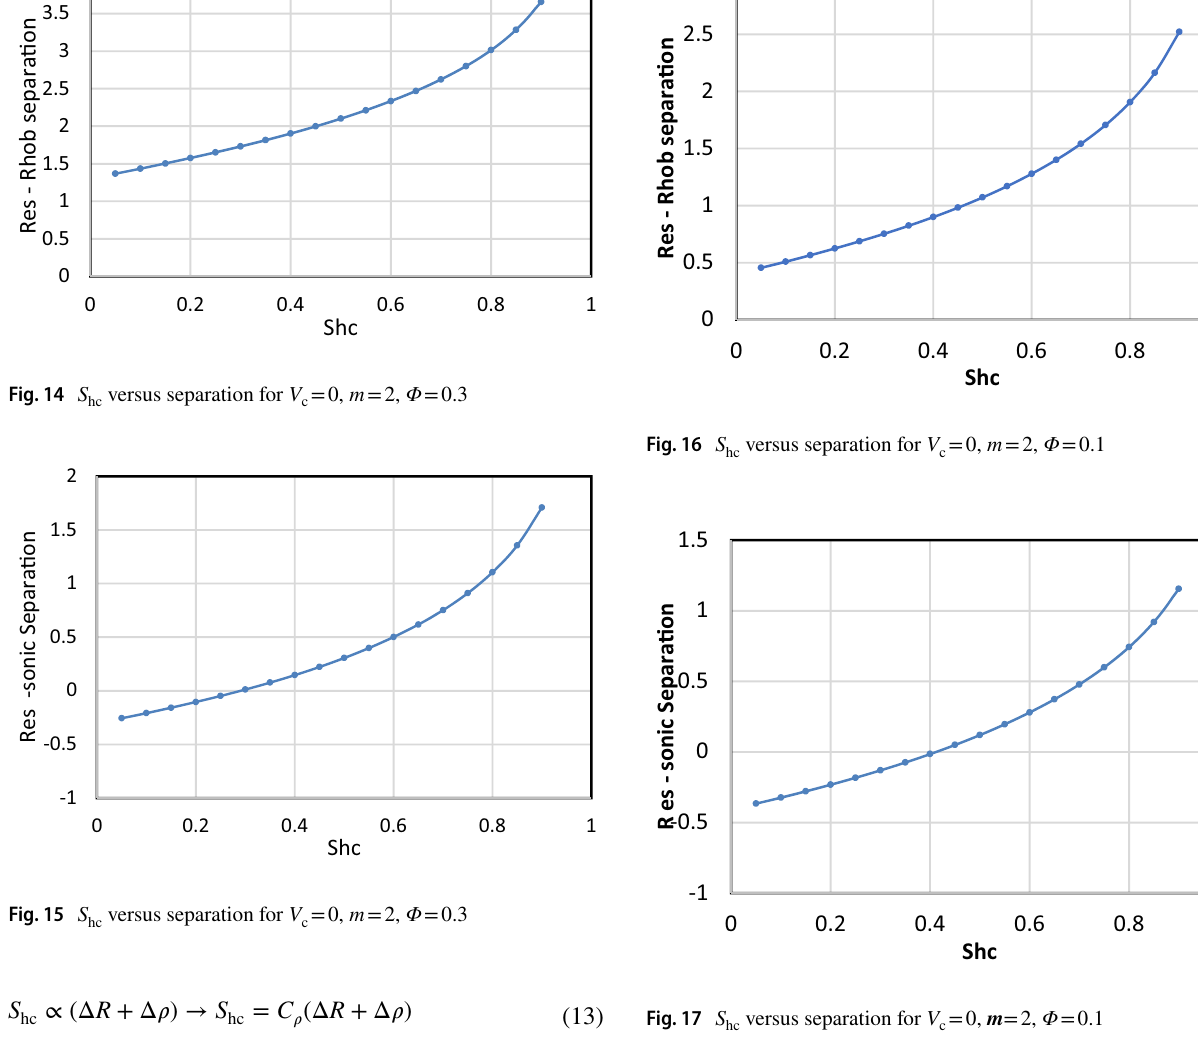
Fig. 17 S hc versus separation for